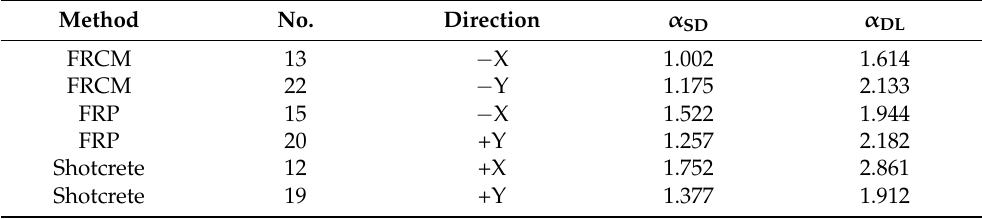
Figure 23. Capacity curves for the model strengthened by shotcrete for the x (blue) and y (red) direction. Table 7. Vulnerability indices for the most significant analysis in the x and y direction for the strengthened